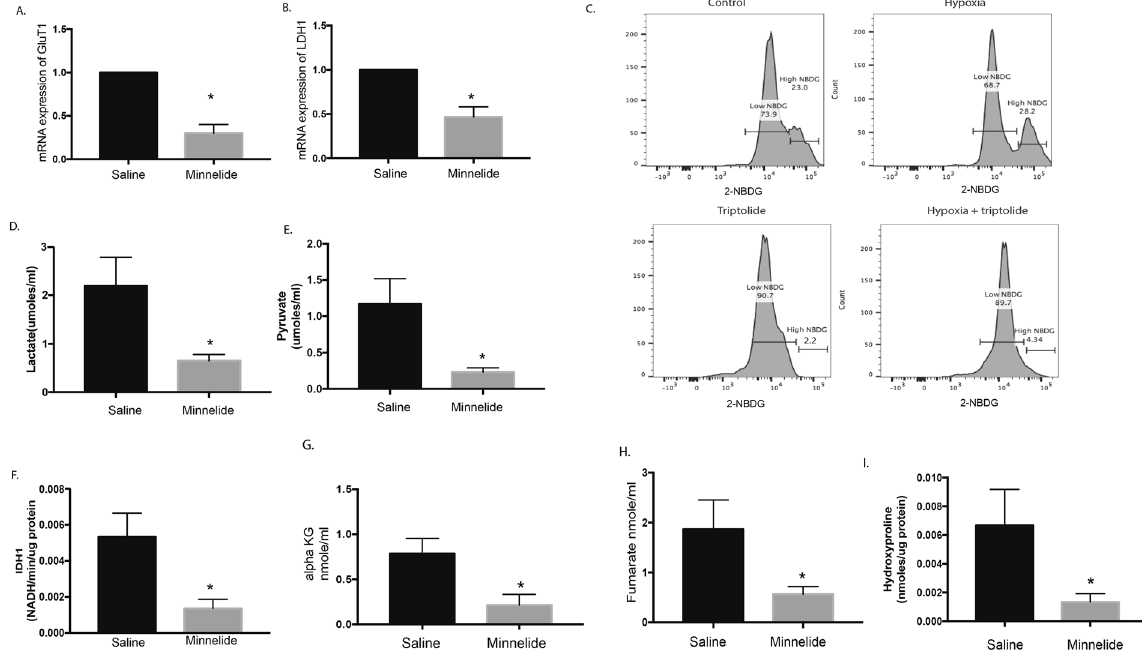
Figure 3. Downregulation of hypoxia by Minnelide affects metabolic pathways: Treatment with Minnelide (0.4 mg/kg) in a KPC animal decreased mRNA expression of GluT1 ( A ) and LDH1 ( B ). It also decreased the glucose uptake of the KPC001 cells in vitro following treatment with a low dose of 50 nM triptolide ( C ). In addition, the amount of lactate ( D ) and pyruvate ( E ) produced was also decreased. Treatment with Minnelide (0.4 mg/kg) in a KPC animals also decreased IDH1 activity ( F ) and alpha ketoglutarate formed ( G ). In addition, fumarate production was decreased following treatment ( H ). Minnelide also decreased the total hydroxyproline in the treated cells indicating a loss in PHD enzyme activity ( I